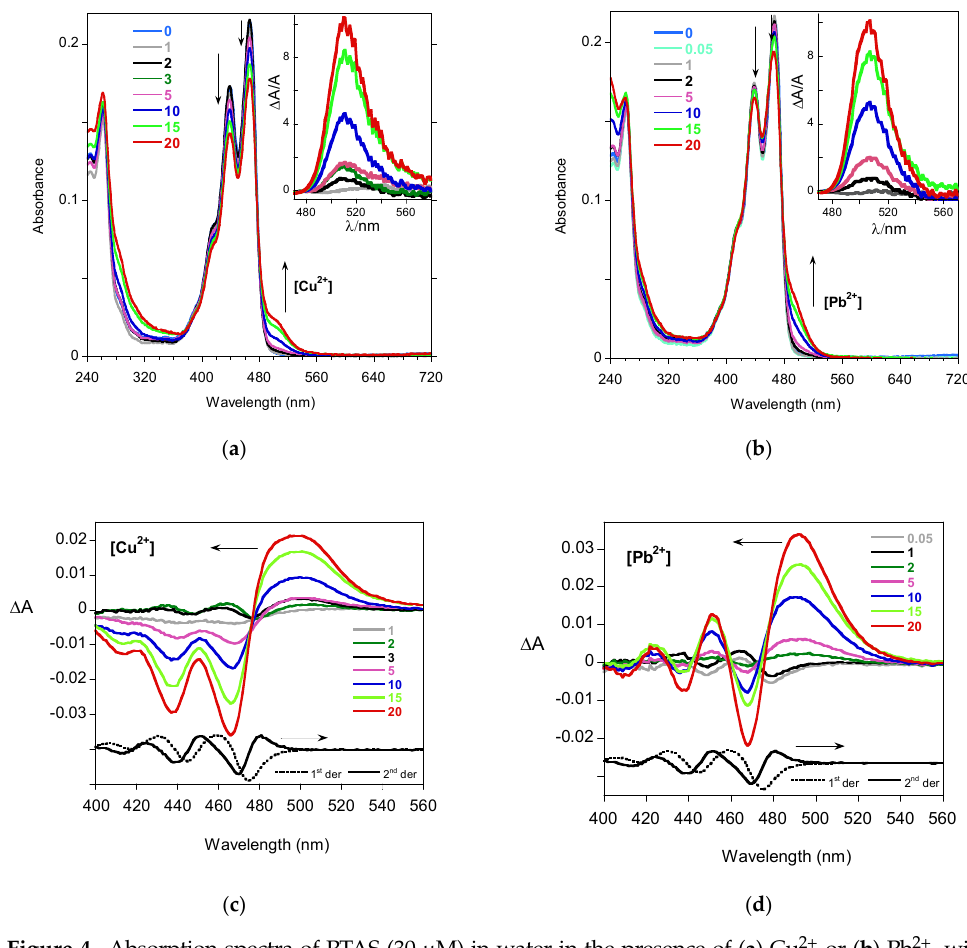
Figure 4. Absorption spectra of PTAS (30 μ M) in water in the presence of ( a ) Cu 2+ or ( b ) Pb 2+ , with different concentrations expressed in µ M. In the insets, the relative absorbance variations ∆ A/A are evidenced in the absorption onset region. The arrows indicate the optical variations when increasing the metal concentration. Absorbance variations ∆ A, as a function of µ M metal concentrations for ( c ) Cu 2+ or ( d ) Pb 2+ , are compared to the first (dotted line) and second (solid line) derivatives of the PTAS absorption spectrum. Absorbance was measured for solutions in 2 mm optical path cells at room temperature. The sensing capability of PTAS for Cu 2+ and Pb 2+ ions was assessed by performing